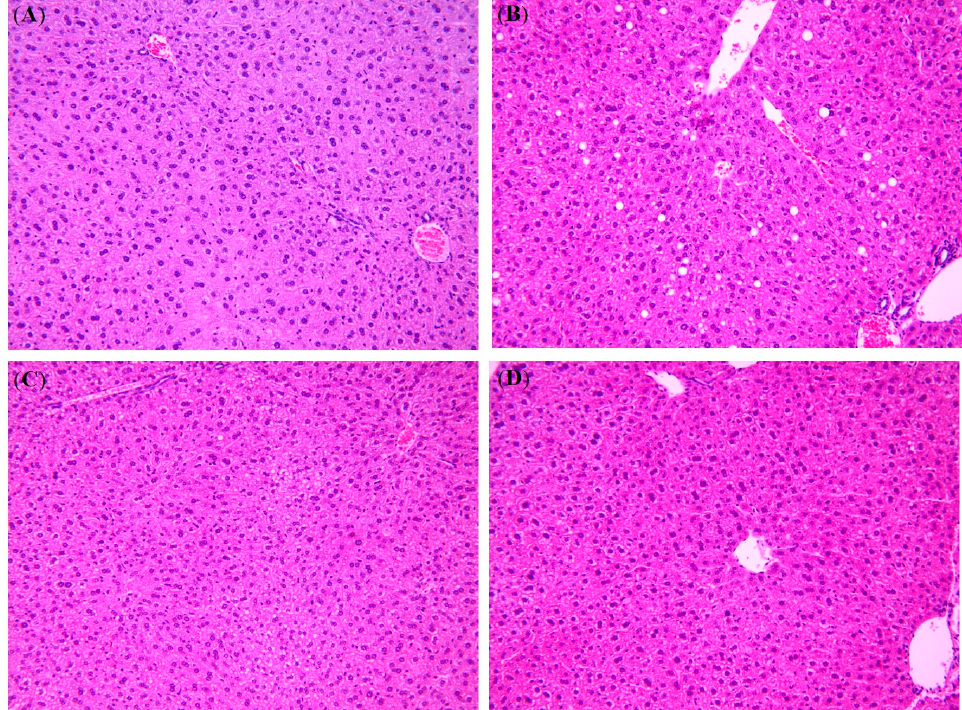
Figure 2. Effect of Nelumbinis Semen powder on histopathological changes in the liver of C57BL/6 mice administered a high-fat diet with low- or high-dose Nelumbinis Semen powder (5% and 10%, respectively). ( A ) Control group (CON), ( B ) high-fat diet (HFD), ( C ) high-fat diet with 5% Nelumbinis Semen powder (HFD-NS5%), and ( D ) high-fat diet with 10% Nelumbinis Semen powder (HFD-NS10%). Hematoxylin and eosin staining showing the fat distribution of hepatocytes (200× magnification).